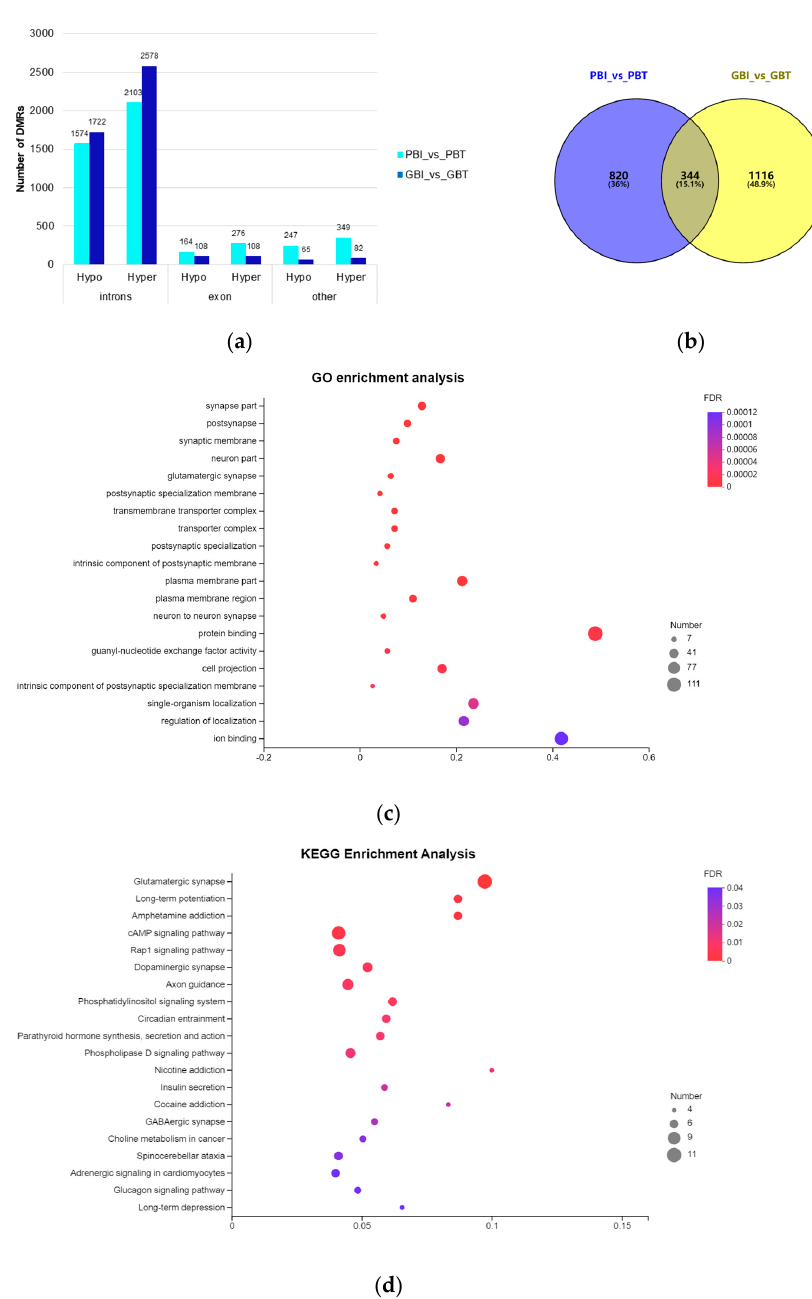
Figure 3. Genome-wide differential methylation regions and functional annotation of the differential methylation genes. ( a ) Distribution of DMR annotated to functional areas. The x-axis represents the number of DMR annotated to the corresponding functional regions, and the y-axis represents the functional regions of the genome. ( b ) Venn diagram of DMGs in the spleen group and liver group. PBI vs. PBT represents the spleen group of Yunnan zebu and Holstein cattle, and GBI vs. GBT represents the liver group of Yunnan zebu and Holstein cattle. ( c ) GO enrichment results of common differential methylation genes in the spleen and liver groups. The x-axis represents en- riched factors, and the y-axis represents the name of the GO pathway. ( d ) KEGG enrichment re- sults of common differential methylation genes in the spleen and liver groups. The x-axis repre- sents enriched factors, and the y-axis represents the name of the KEGG pathway.